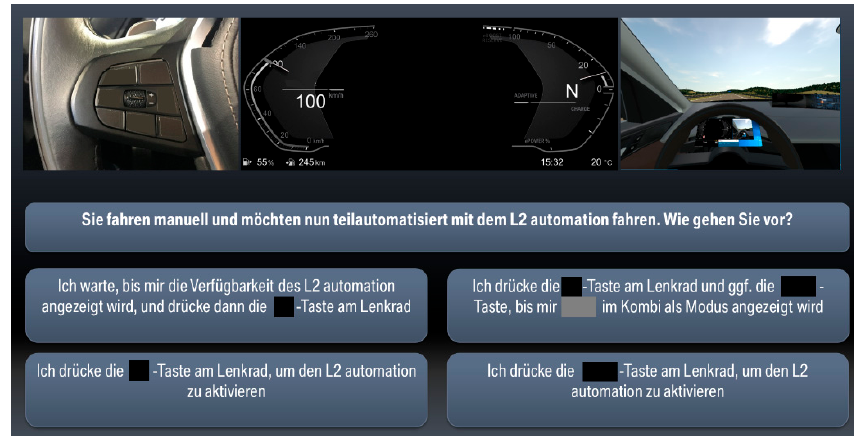
Figure 3. Layout of interactive tutorial with operating element ( upper left ), instrument cluster ( upper middle ), driver’s view ( upper right ), user task, and four alternative answers.